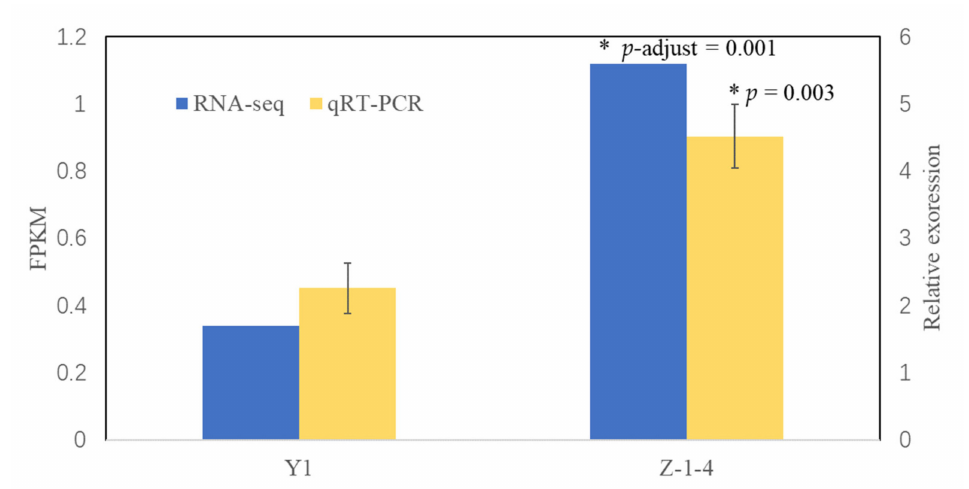
Figure 4. Expression analysis of McEPFL2 in fruit epidermal tissues in Z-1-4 and Y1 by RNA-seq (blue) and qRT-PCR (yellow). Error bars are mean ± standard error. Significance of expression level was made between the two genotypes in each experiment with t -tests. Asterisks (*) means p < 0.05 by student’s t